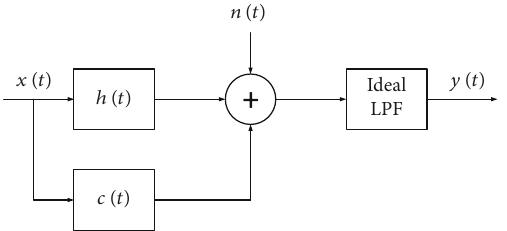
Figure 1: Random target signal model for transmitted waveform based on MI.